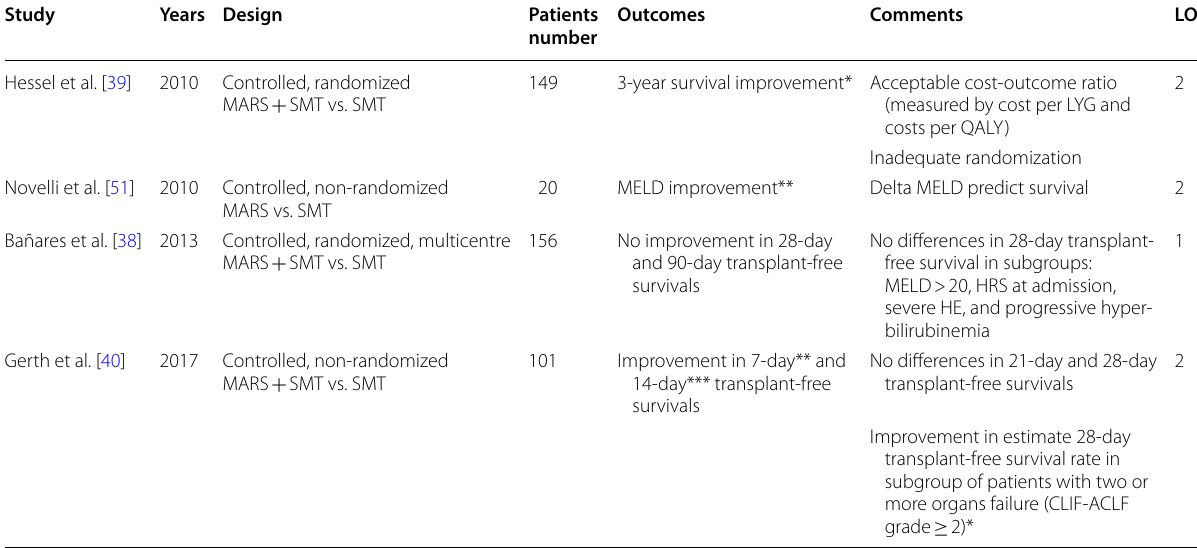
Table 2 Studies with clinical endpoints for AoCLF using